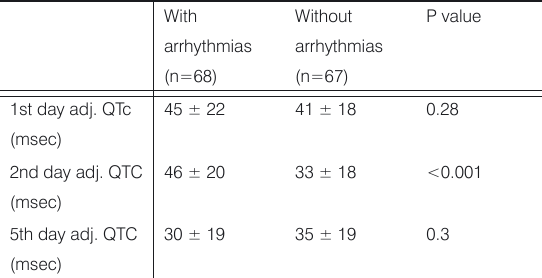
Figure 2. Shows the area under the ROC curves for adjacent QTc dispersion for the prediction of ventricular arrhythmias on the second day after acute myocardial infarction. The cut point that better optimizes the values of sensitivity and specificity are for values ł 45